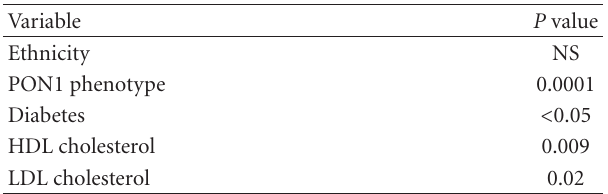
Table 3: Mixed model ANOVA analysis with PON1 mass as the dependent variable.